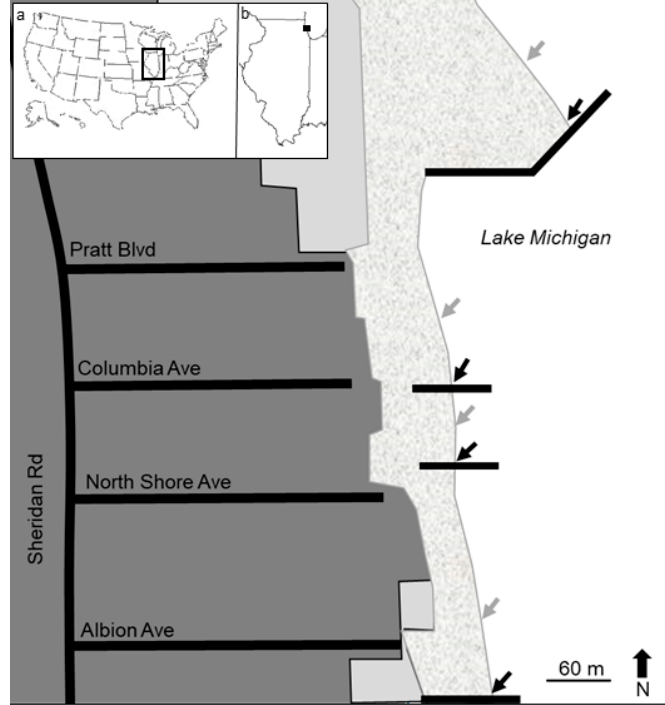
Figure 1. Map of study sites. Dark gray = city blocks, light gray = city parks, stippled = sandy beach, and white = Lake Michigan. Sites are named according to intersecting streets, and pier locations are marked in black. Arrows show location of pier adjacent (black) and non-pier adjacent (gray) transects. Insets: ( a ) the state of Illinois in context of the United States, and ( b ) location of the study beaches within Illinois.